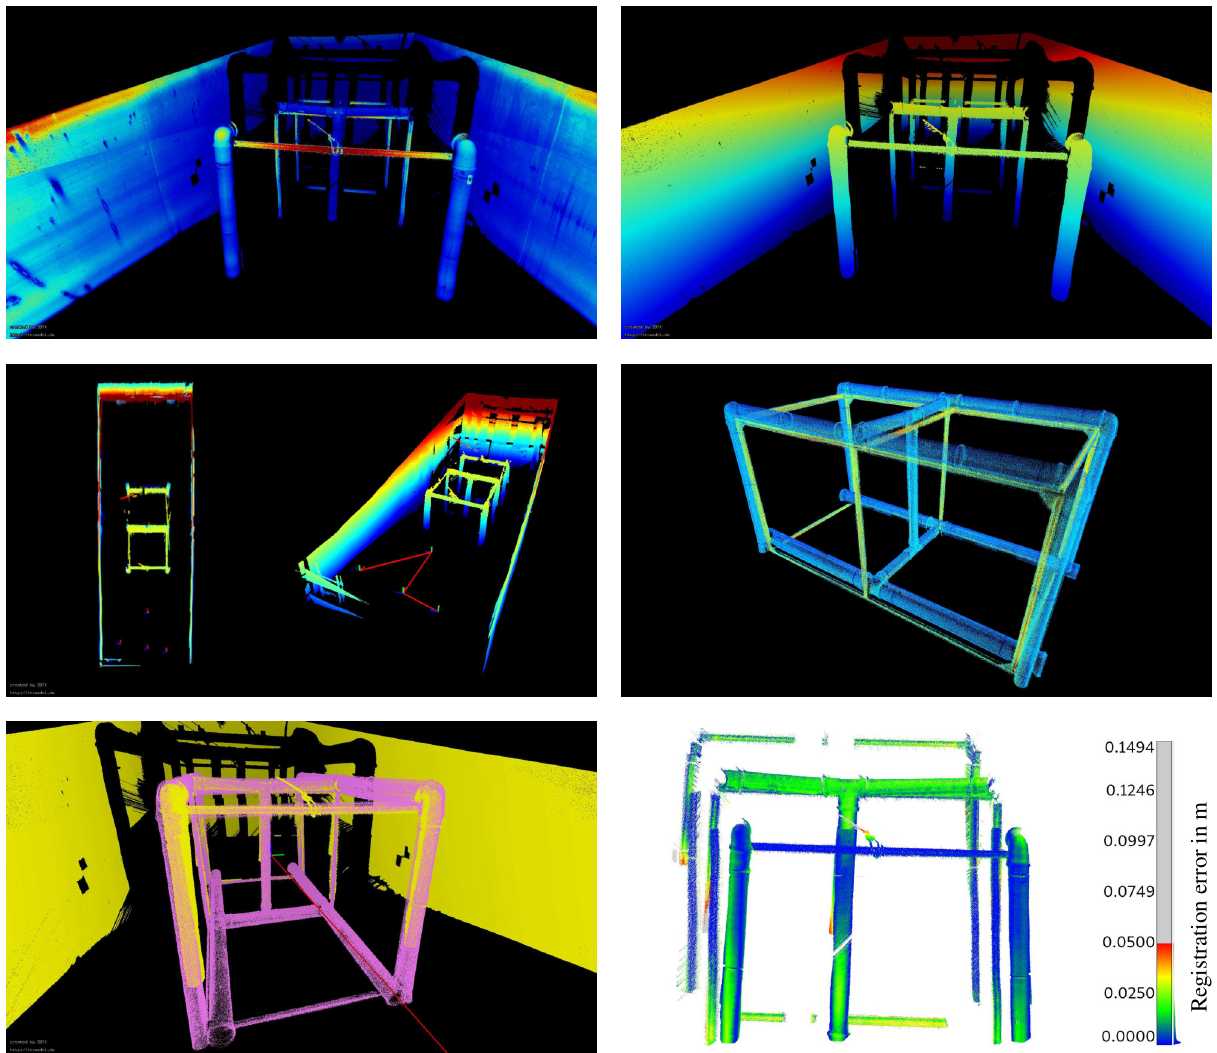
Figure 7. Results of underwater scanning from a tripod. Top left: Point cloud of a scan of the pipe structure colored by intensity, Top right: Same scan colored by height., Middle left: Top view and perspective view of registered point cloud from four scans, Middle right: Reference scan of the structure captured in air before the experiments, Bottom left: Underwater point cloud in yellow and reference scan in pink, Bottom right: Registration error between reference scan and underwater